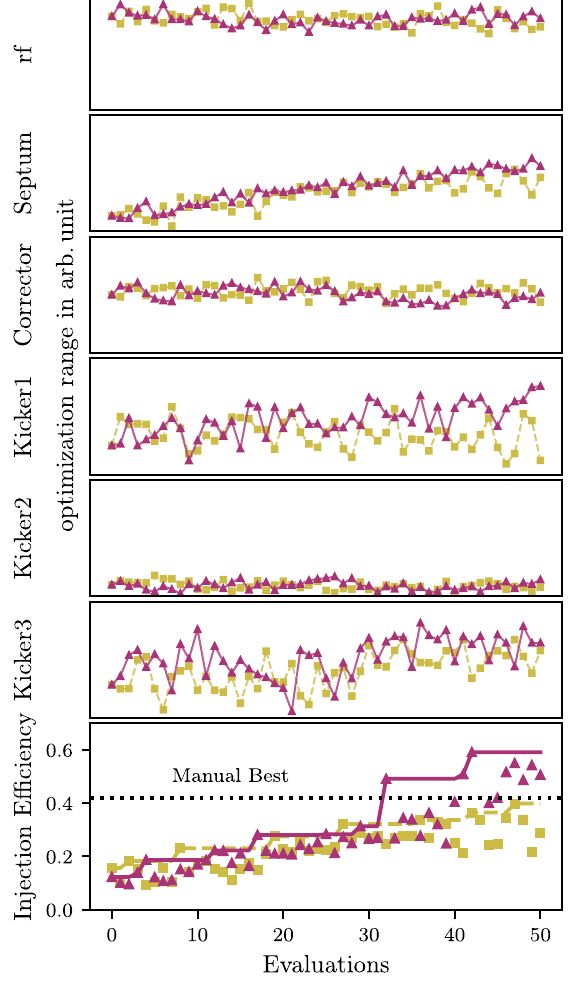
FIG. 9. Two runs with the highest (purple, solid) and lowest (yellow, dashed) optimized injection efficiency achieved are plotted out of all five BO runs with UCB acquisition using the new power supplies. The evolution of the input parameters and the resulting objective function are shown over the optimization steps, where the vertical limit is the total allowed optimization range, respectively. The bottom plot shows the measured injection functions (markers) with the cumulative best results (lines). The dotted line depicts the 90% quantile of the injection efficiency obtained by manual operation in a month prior to the shutdown period. Even the BO run with the worst performance achieved a comparable result as the manual baseline.